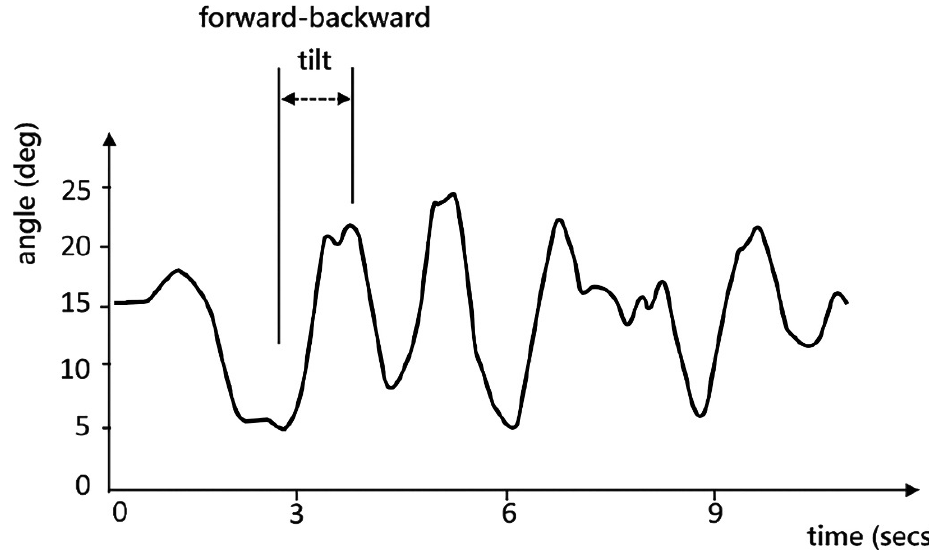
Figure 3. A sample waveform of the trunk forward-backward tilt angle.